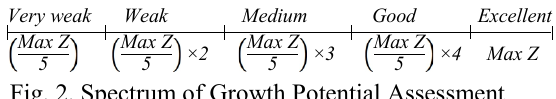
Fig. 2. Spectrum of Growth Potential Assessment